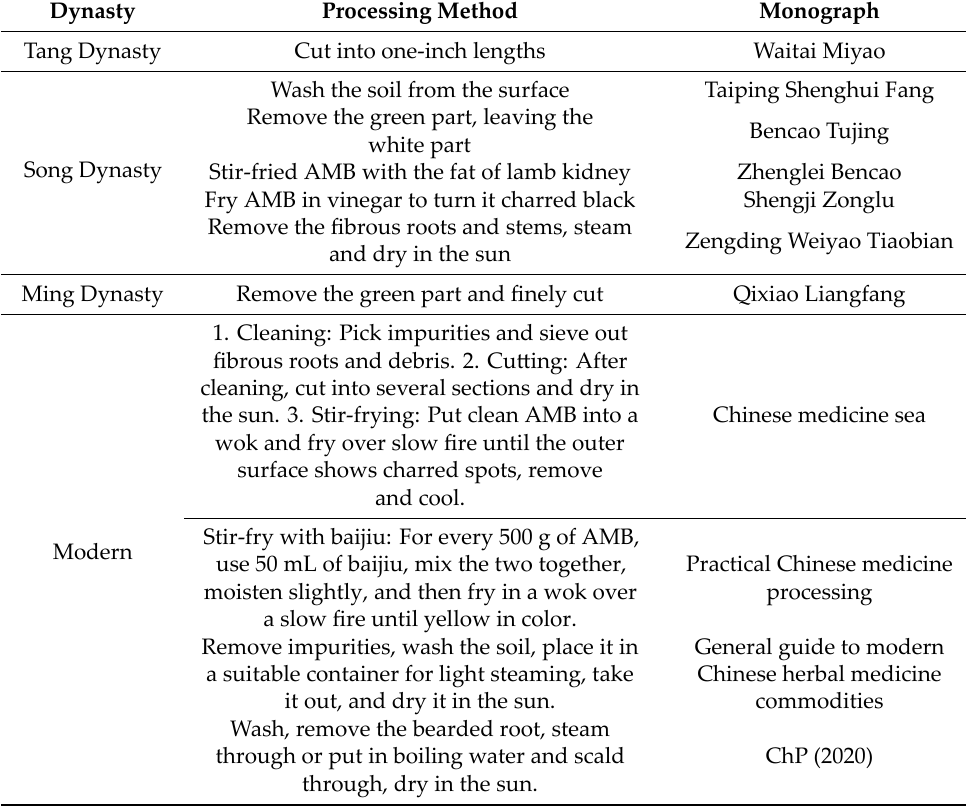
Table 2. Different processing methods of AMB in different